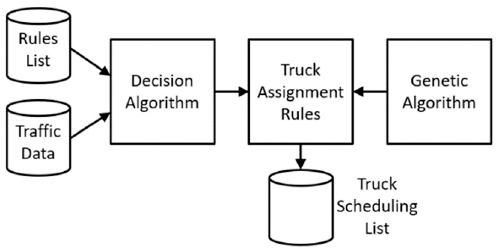
Figure 6. The schematic representation of the proposed method.